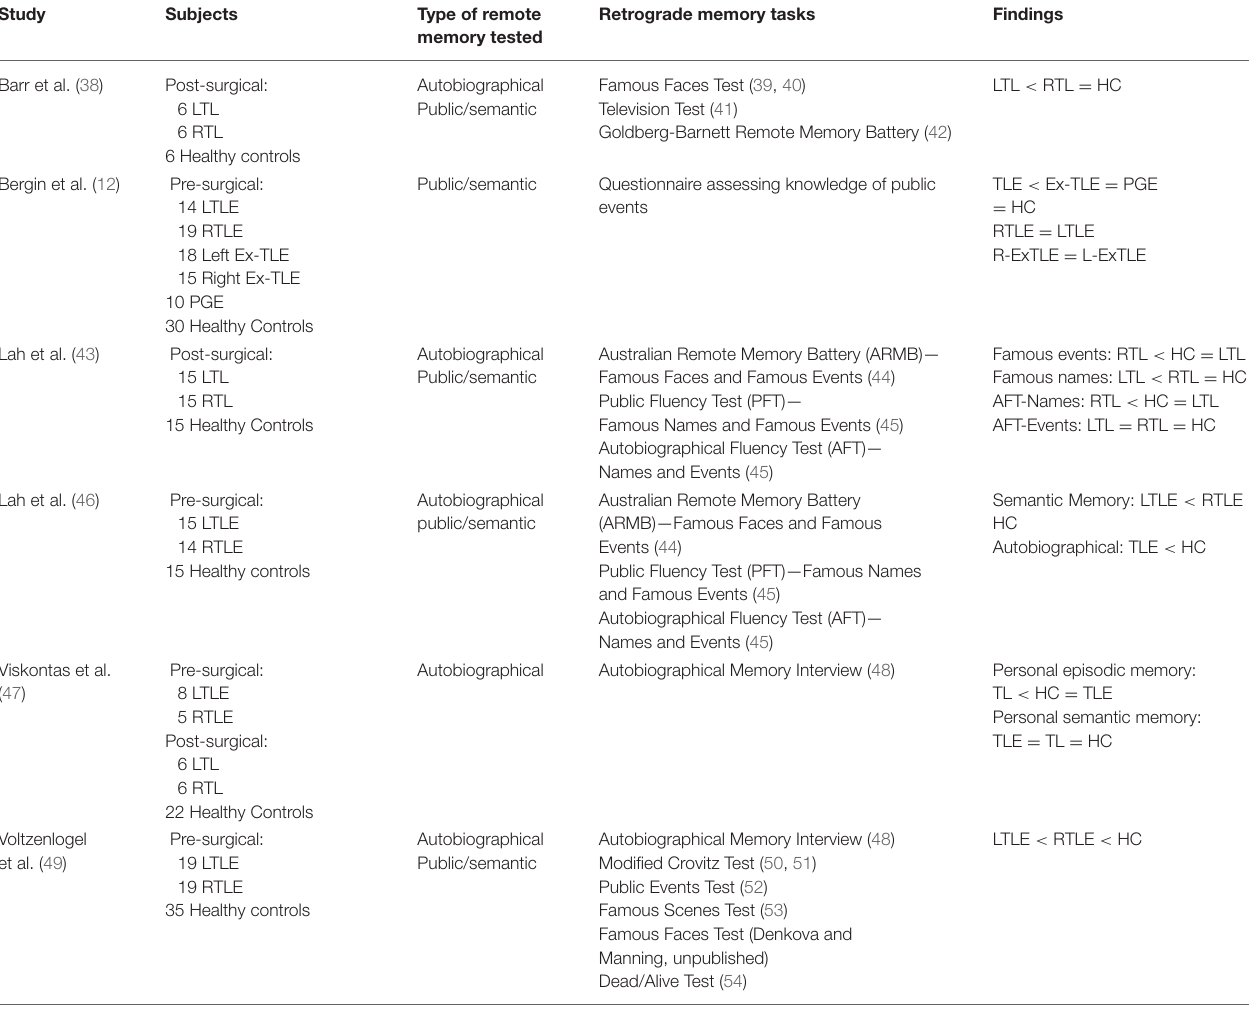
TABLE 1 | Remote memory deficits in epilepsy